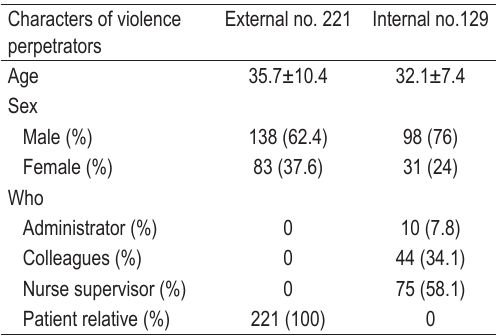
TABLE 4. Sociodemographic characters of violence perpetrators against nurses, Minia district